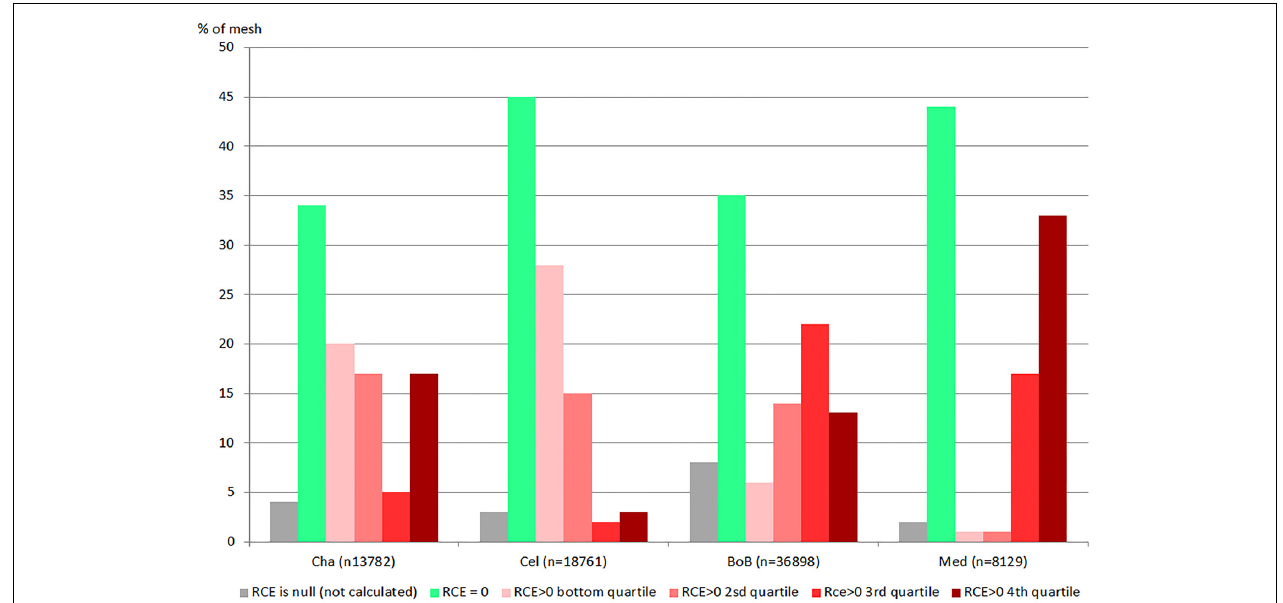
FIGURE 6 | RCE quartile distribution in percentage of grid cell in each French waters of MSFD marine subregions. “Cha” English Channel, “Cel” Celtic Seas, “BoB” Bay of Biscay and “Med” Western Mediterranean Sea.